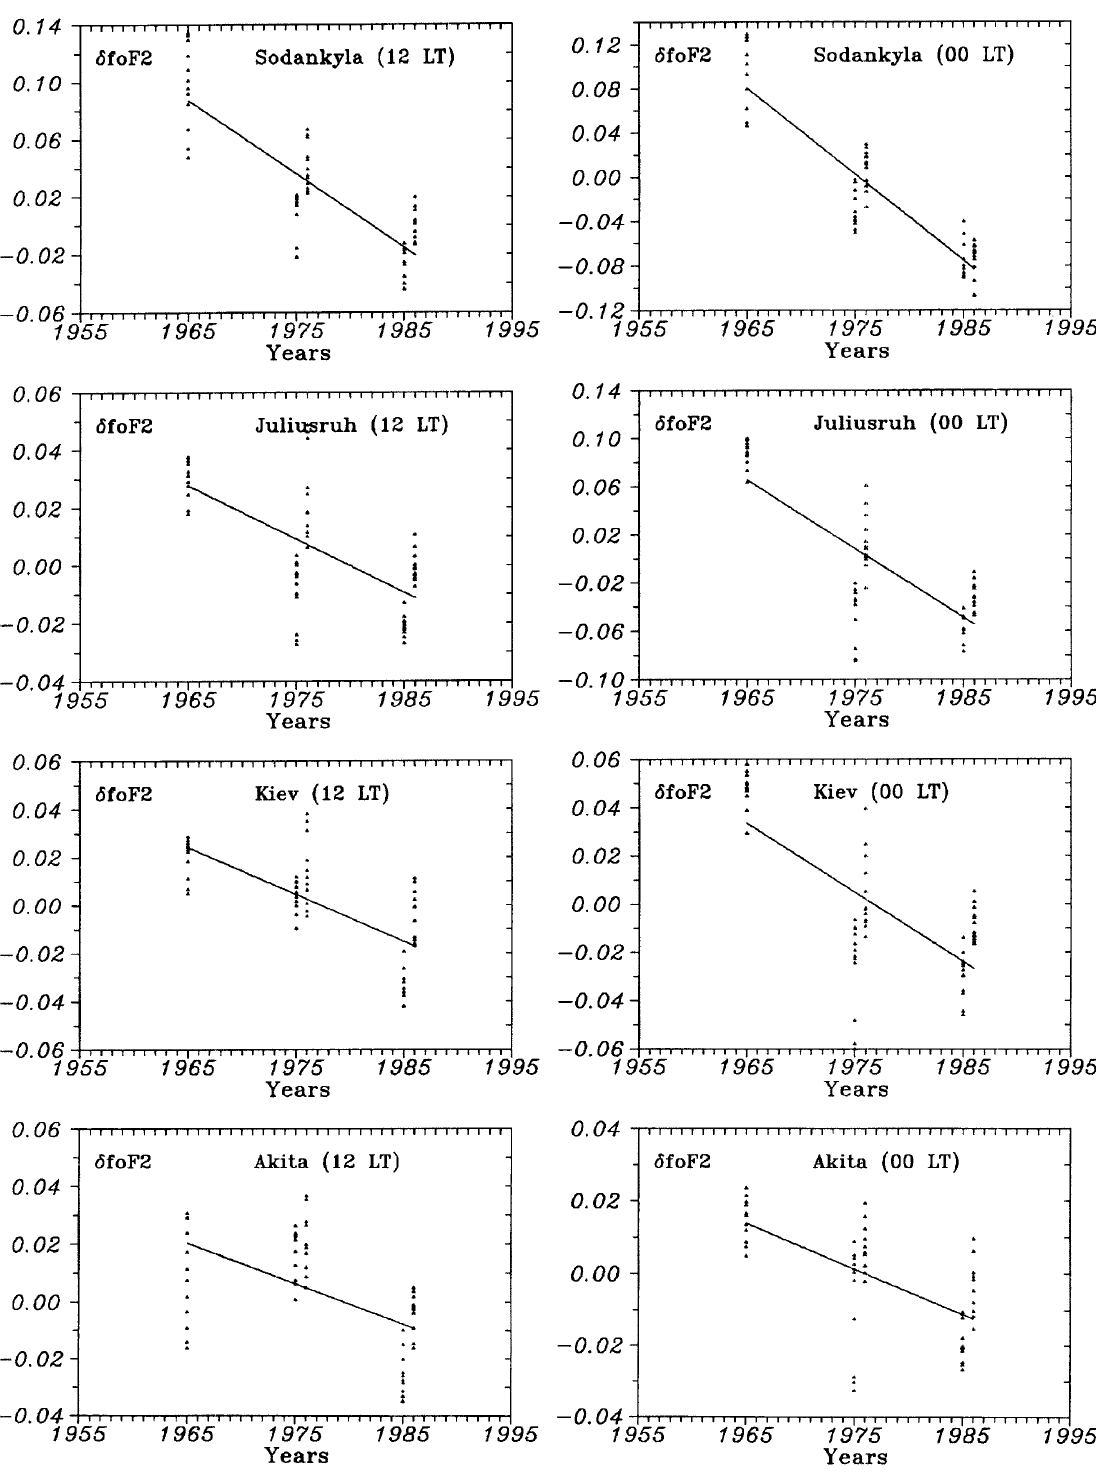
Fig. 1. Some examples of annual mean f oF2 trends for daytime and nighttime hours using only years of solar minimum. Triangles are individual monthly d f